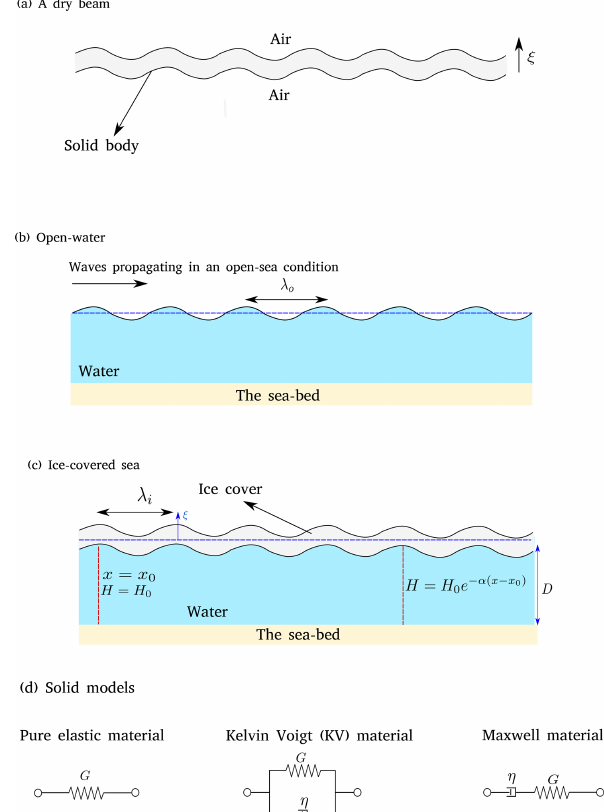
Figure 1. A pictograph of the problem and the different patterns of rheological behavior considered for the ice layer. Panels (a) and (b) repetitively show a dry beam and waves propagation in an open- water sea. Panel (c) shows waves propagating in an ice-covered sea. Panel (d) shows different rheological behavior that can be consid- ered for the